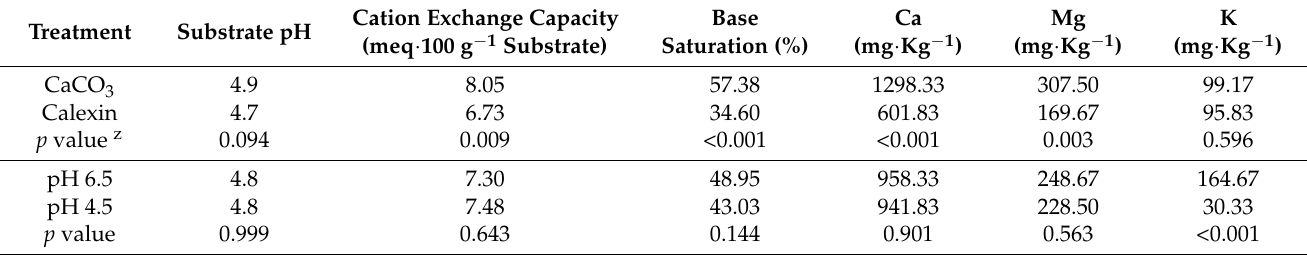
Table 2. Substrate characteristics after 75–77 days of growing ‘Emerald’ southern highbush blueberry with contrasting substrate amendments and fertigation